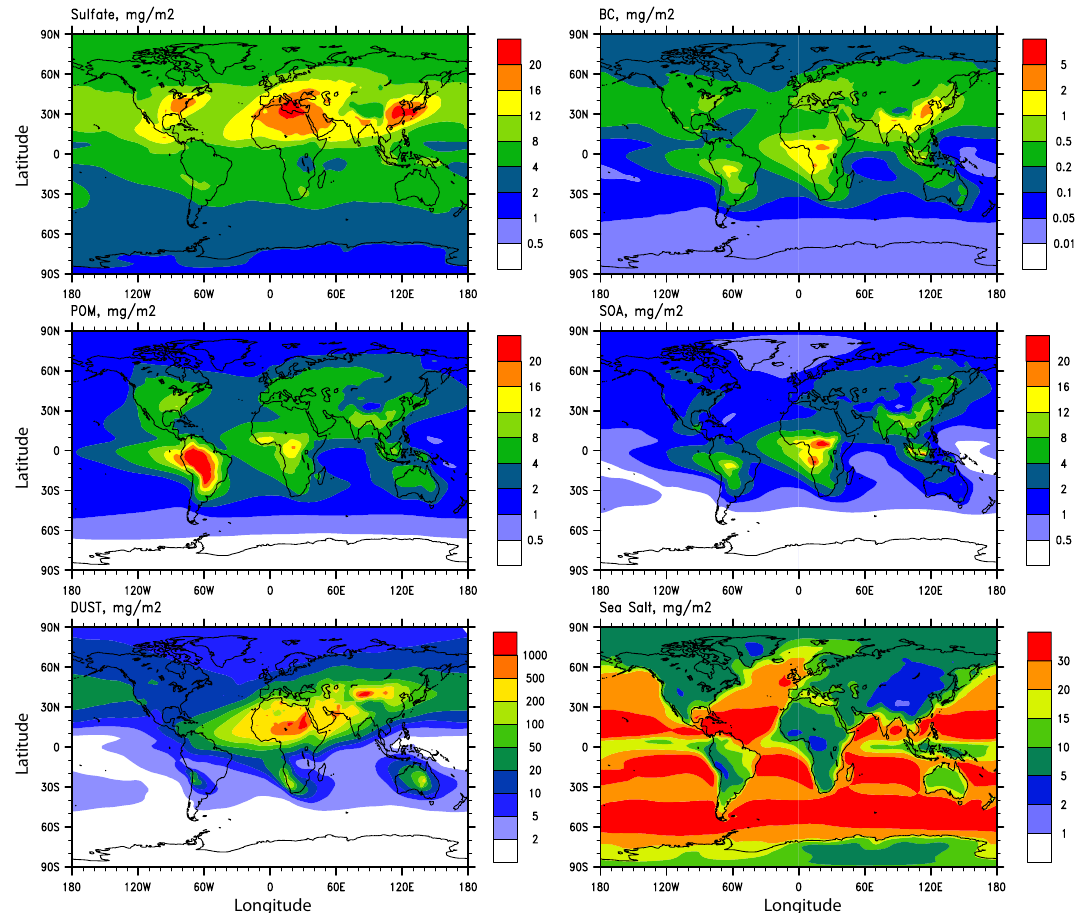
Longitude Longitude Fig. 1. Vertically integrated annual mean concentrations (mgm − 2 ) of sulfate, BC, POM, SOA, dust, and sea salt predicted by the model. Figure 01 17.8%, which is larger than the AeroCom median